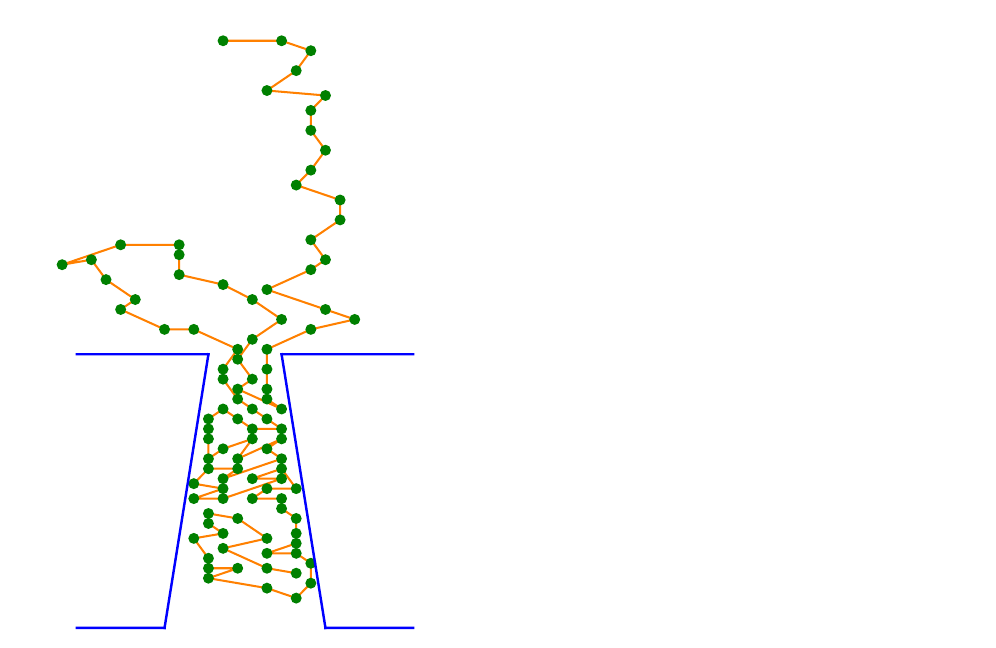
Figure 1. A schematic view of a chain-like body when passing through a conical